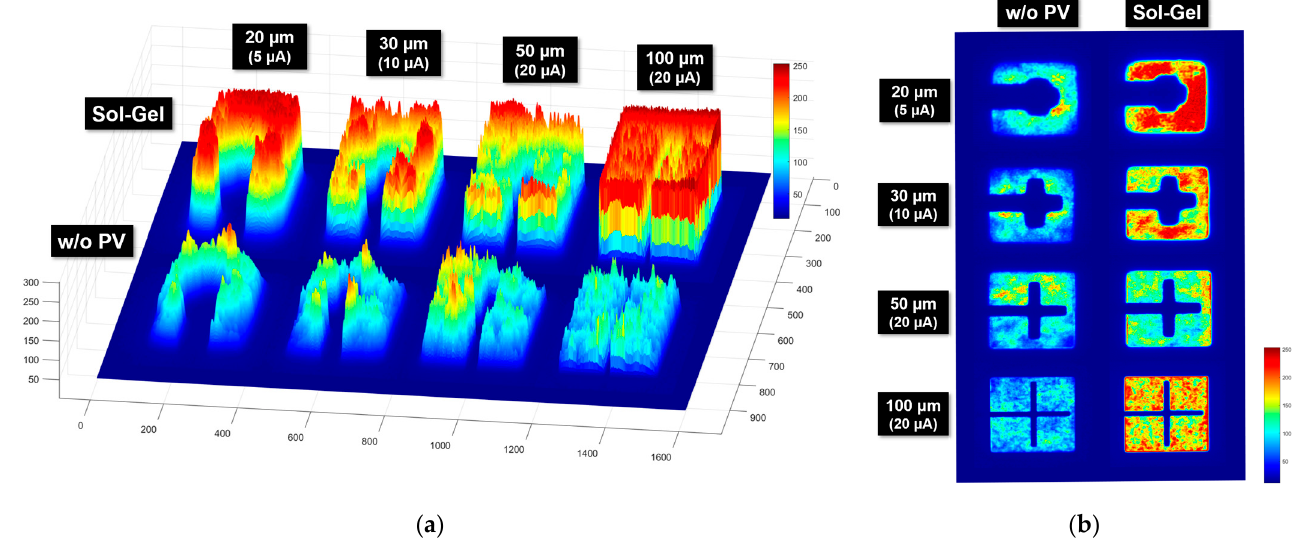
Figure A2. EL emission images of S1, S2, and S3 for ( a ) 30 ×30 μ m, ( b ) 50 × 50 μ m, and ( c ) low-current density emission.